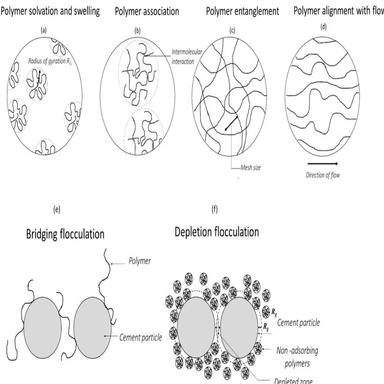
The main mechanism of actions of the different types of VMA.